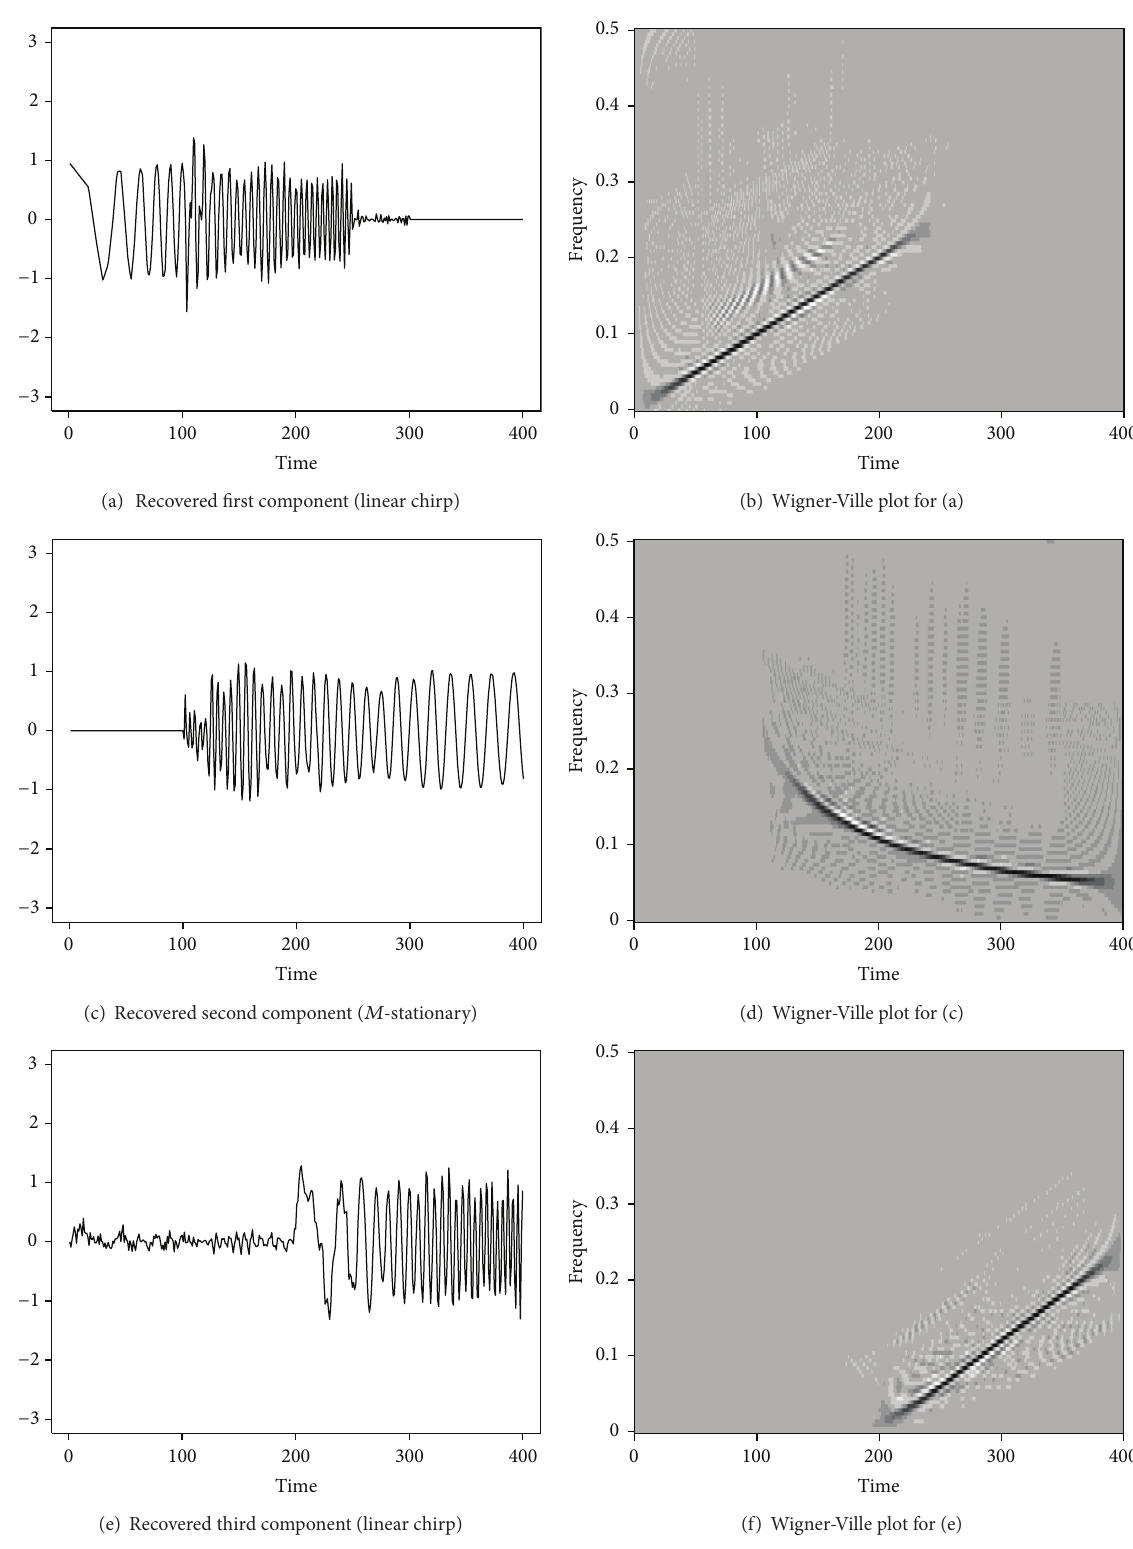
Figure 11: (a), (c), and (e): recovered components for Example 5 and (b), (d), and (e): the corresponding Wigner-Ville